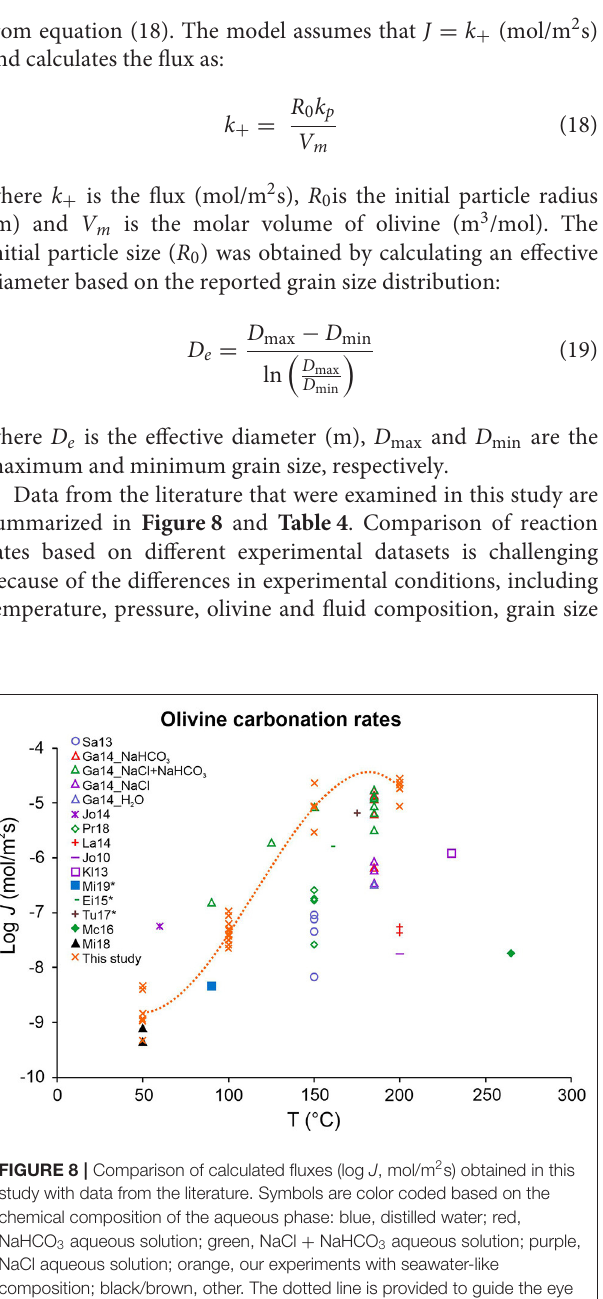
Frontiers in Climate |